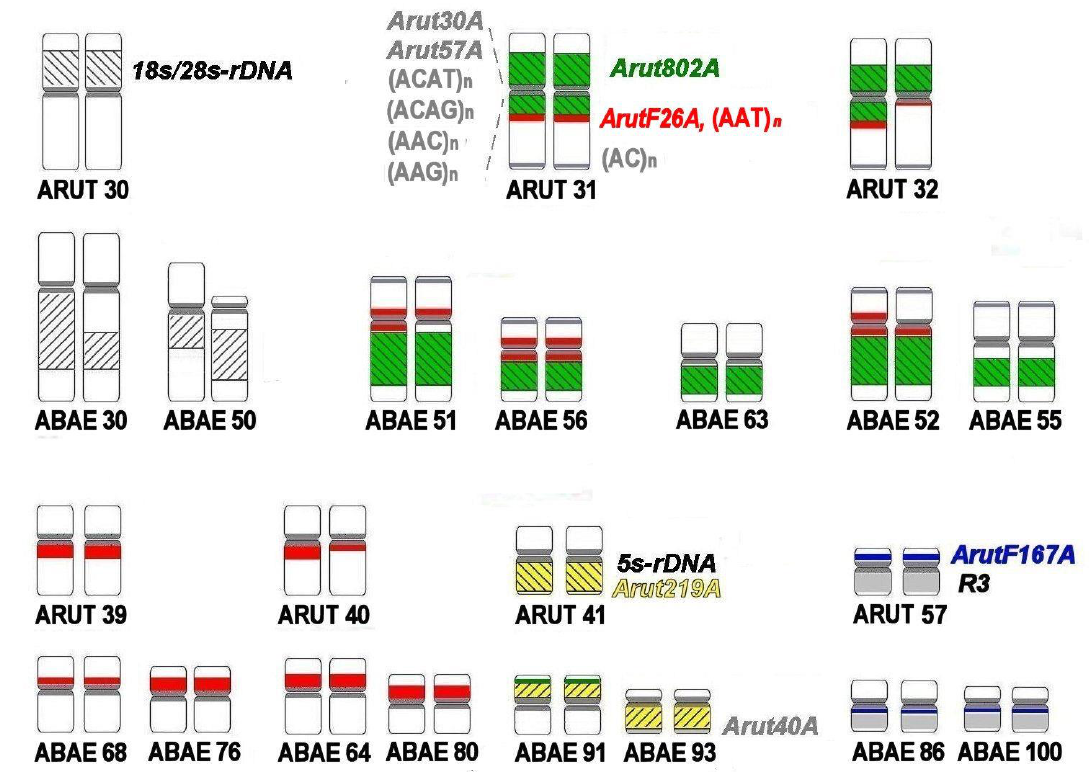
Figure 9. Scheme of tandemly arranged repetitive DNA dynamics in the karyotypes of sterlet (ARUT) and Siberian sturgeon (ABAE), based on the chromosomal localizations of sterlet-specific repetitive DNAs and microdissection-derived painting probes on Siberian sturgeon chromosomes. The names of repetitive and chromosome-specific probes are given near the chromosomes of their origin.